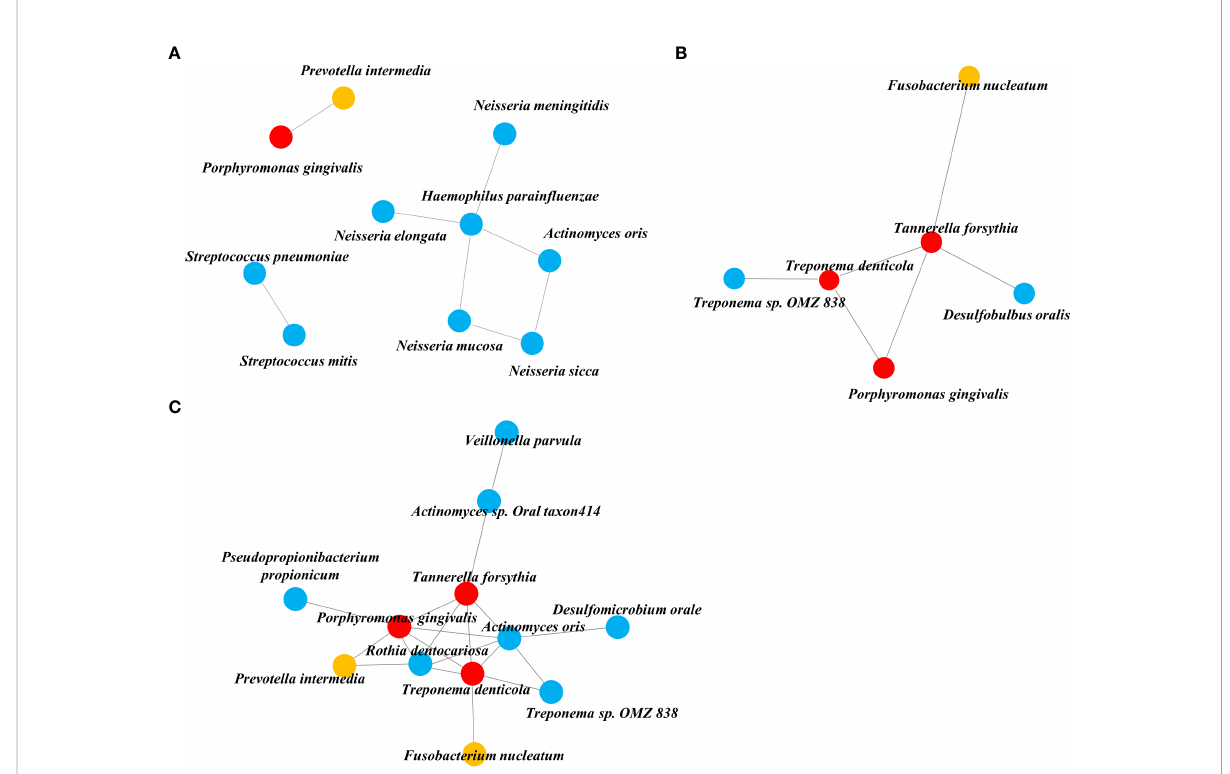
FIGURE 3 Co-occurrence network inferred from the SparCC algorithm applied to relative abundance species data. (A) NA, (B) PD, and (C) PD_DM. The orange circle represents the orange complex and the red circle represents the red